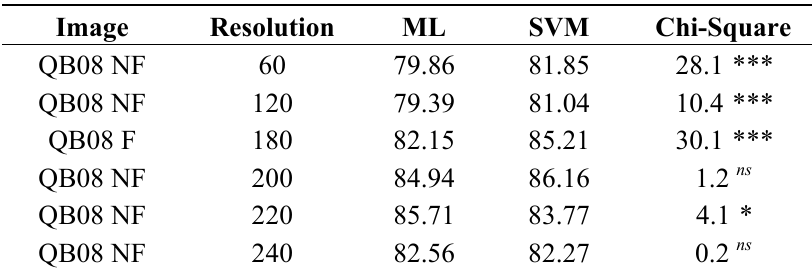
Table 5. The McNemar Chi-squared test for comparing the overall accuracy (%) of the classifications by ML and SVM methods in the July 2008 Quickbird image with different spatial resolutions. Significant differences are indicated as ns (not significant);